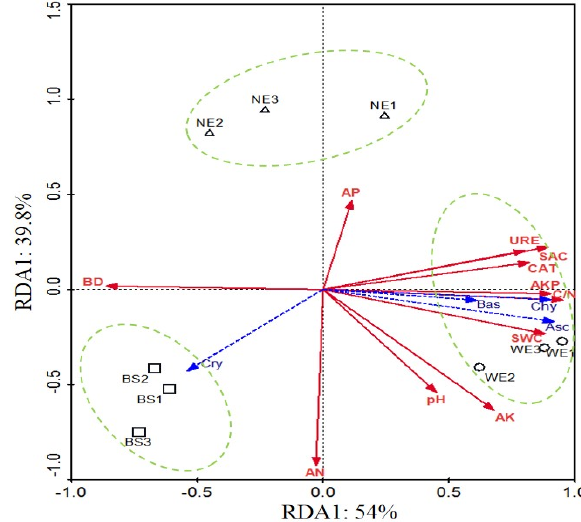
Figure 7. Redundancy analysis of relationships between physicochemical parameters of soil and dominant phyla of fungal communities inoculated with ectomycorrhizal fungi (WE), not inoculated with ectomycorrhizal fungi (NE), and of bulk soil (BS). Red arrows refer to physicochemical prop- erties of soil, available nitrogen (AN), available phosphorus (AP), available potassium (AK), total carbon/total nitrogen (C/N), bulk density (BD), soil water content (SWC), urease (URE), saccharase (SAC), catalase (CAT), and alkaline phosphatase (AKP). Green arrows refer to Chytridiomycota (Chy), Ascomycota (Asc), Basidiomycota (Bas), and Cryptomycota (Cry).